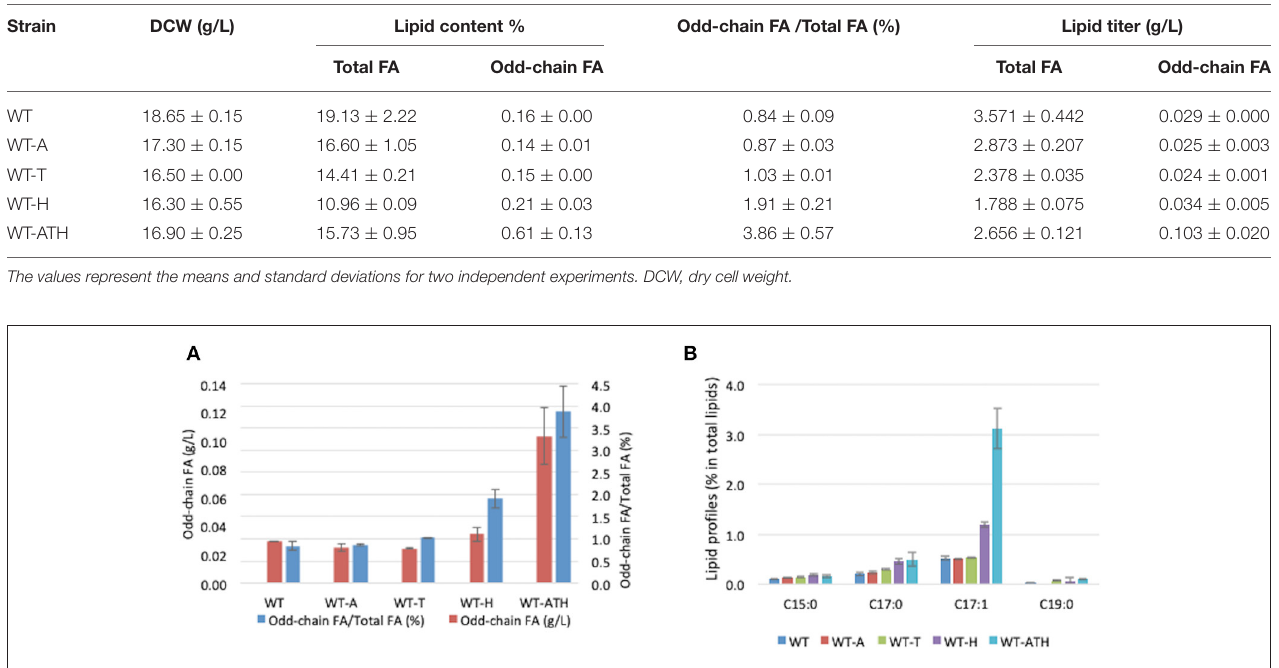
FIGURE 3 | Odd-chain fatty acid production and profiles for the wild-type and engineered strains. (A) Odd-chain fatty acid (FA) titers (g/L) and the percentage of odd-chain FAs relative to total FAs in the wild-type (WT) and engineered strains. (B) Odd-chain FA profiles (percentage of each FA out of total FAs) of the WT strain and engineered strains. WT, control strain; WT-A, strain expressing module A; WT-T, strain expressing module T; WT-H, strain expressing module H; WT-ATH, strain expressing the full pathway (all three modules). The results represent the means and standard deviations for two independent